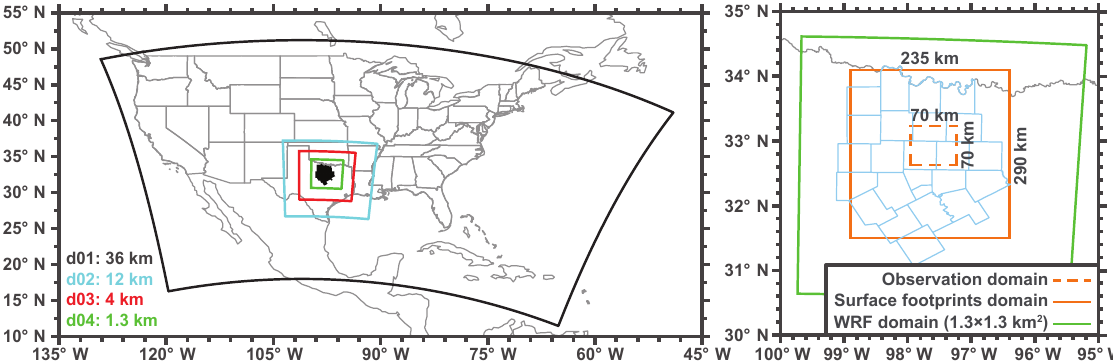
Figure 1. High-resolution OSSE domain. Left panel shows the successive nested WRF domains at 36, 12, 4, and 1.3km spatial resolutions, with the coarser domains providing initial and boundary conditions for the finer domains. Black shaded region is the Barnett Shale region in Texas. Right panel shows the domain for the OSSE. Green box is the innermost 1.3km WRF domain, dashed orange box is the observation domain, and solid orange box is the domain over which the footprints are computed. Light blue lines indicate the counties in the Barnett